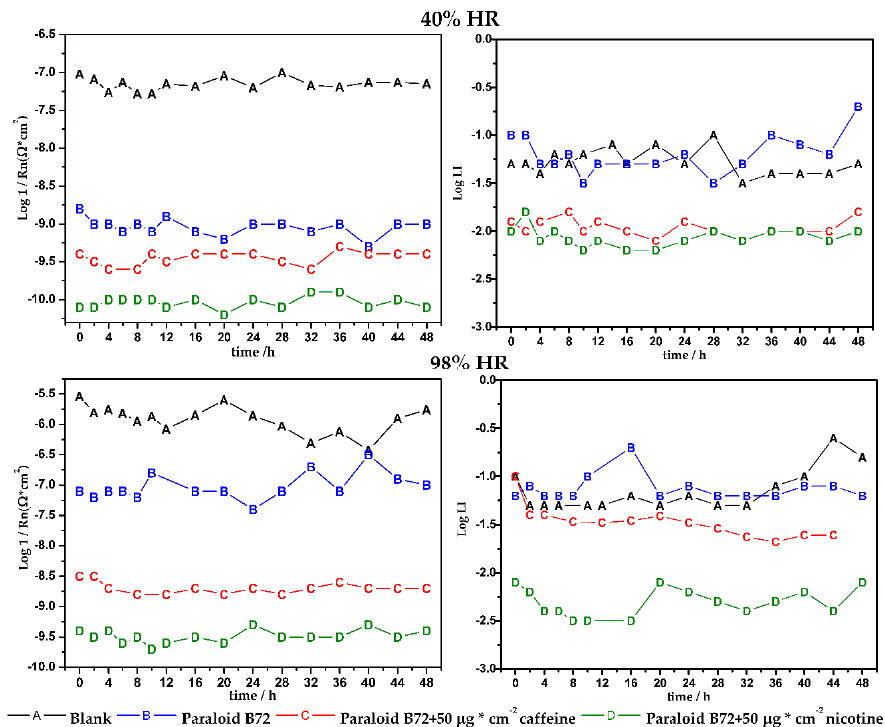
Figure 6. 1/ R n (proportional to the corrosion rate) and the location index (LI) according to the times for different coatings in 40% and 98% relative humidity.